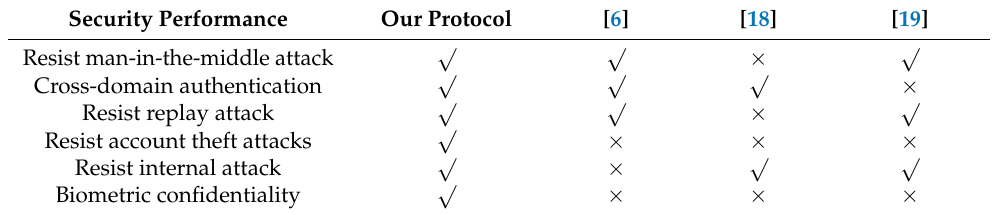
Table 2. Comparison of protocol